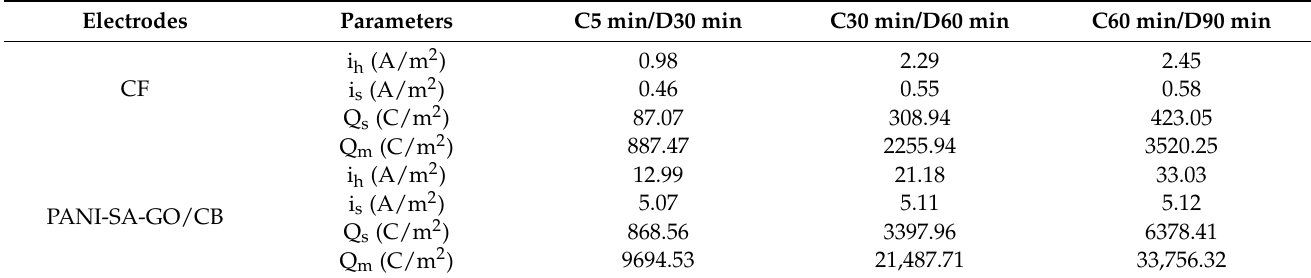
Table 2. The parameter of discharging curves with blank anode and modified anode.